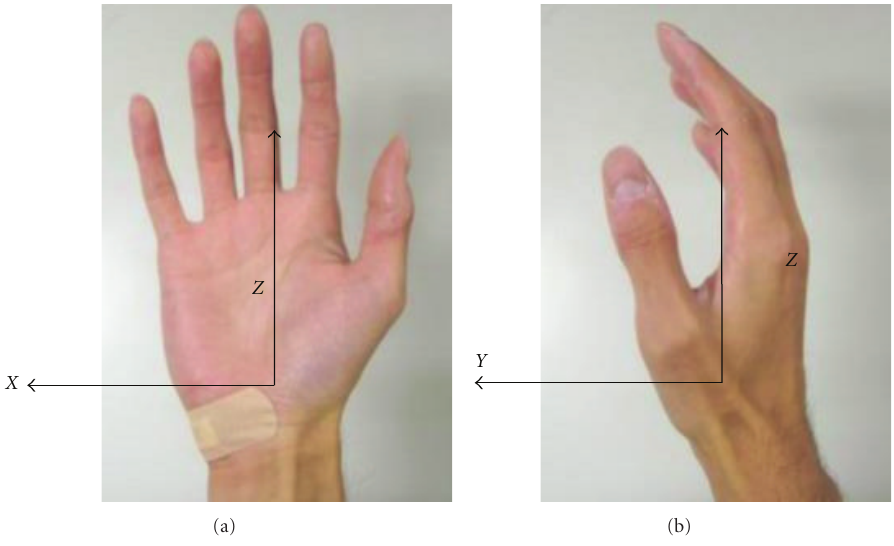
Figure 7: The system coordinate and origin. Table 2: Questionnaire scores from